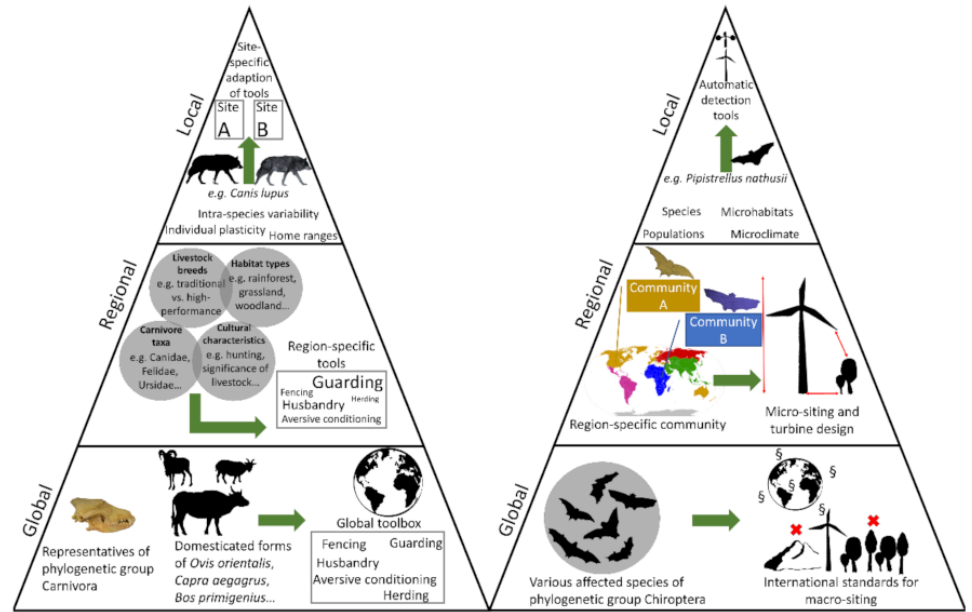
Figure 4. Conceptual framework: stepwise adjustment of measures to mitigate HWC from the global to the local scale, including a gradual adjustment from a broad systematic category towards a certain species, sometimes a population, or group of individuals. Requirement: global distribution and a certain degree of ecological similarities among the representatives of a monophylum involved in HWC (specification of the wildlife concept); see text for further